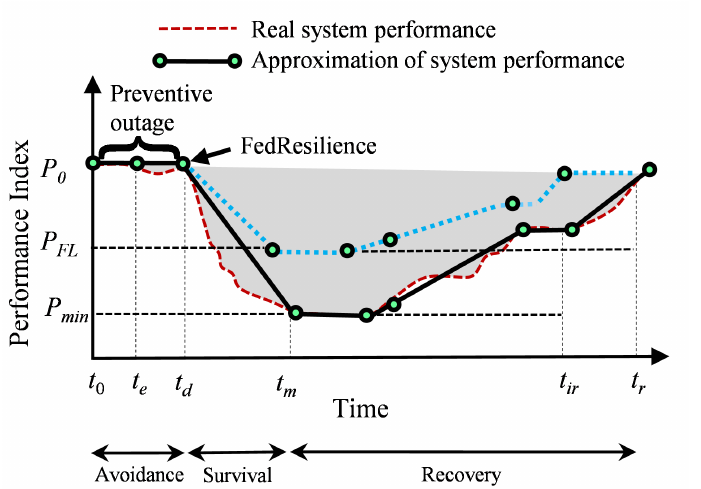
Figure 28. Eight-point linear approximation of the performance of the FedResilience algorithm during a disaster